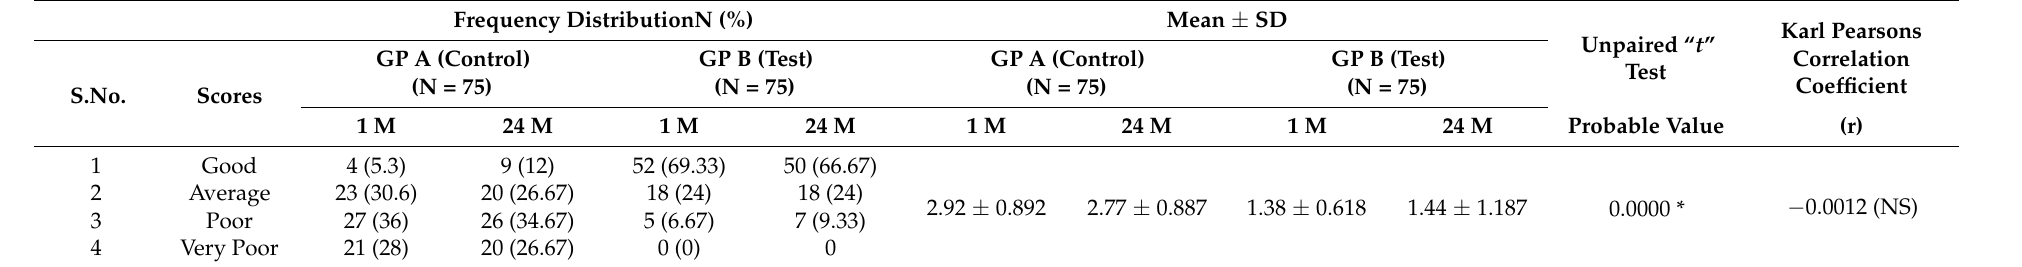
Table 2. Frequency distribution of various grades of DPI (denture plaque index) scores with means compared among subjects of both groups.